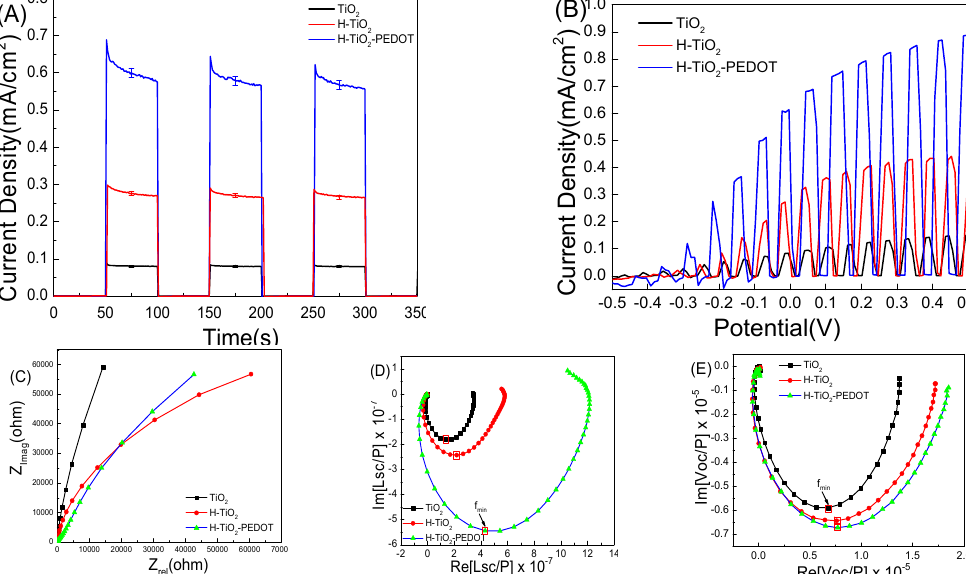
Figure 5. The current density-time curves (I-T) ( A ), the current density-potential (I-V) ( B ), AC impedance spectroscopy (EIS) ( C ), intensity modulated photocurrent spectroscopy (CIMPS) ( D ) and intensity modulated photovoltage spectroscopy (CIMVS) ( E ) of series photoelectrodes.